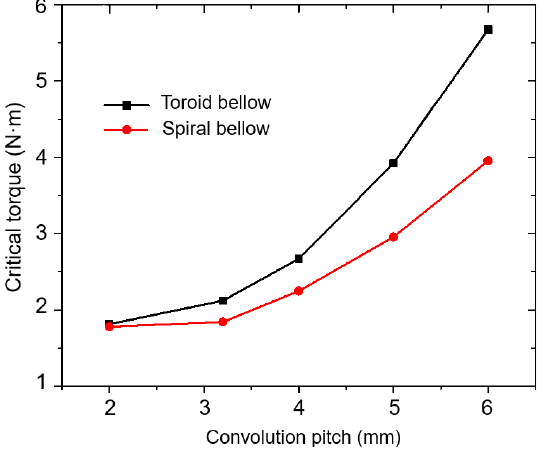
Figure 12. Curve of critical torque versus convolution pitch.